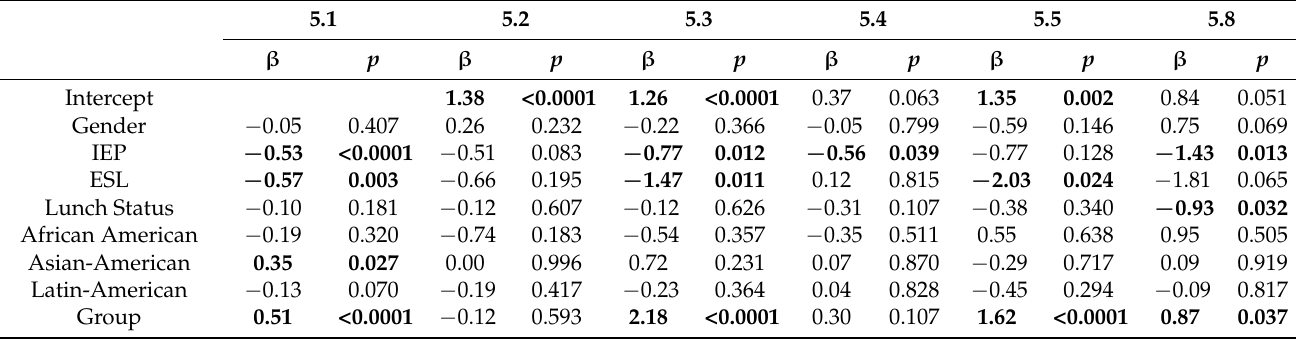
Table 4. β -Weights for Terms in Final Models Predicting Each Reading Standard. Bold-faced, asterisked terms were significant at α = 0.05; t / z , df , and p values are not reported to conserve space; cells with “NA” could not be